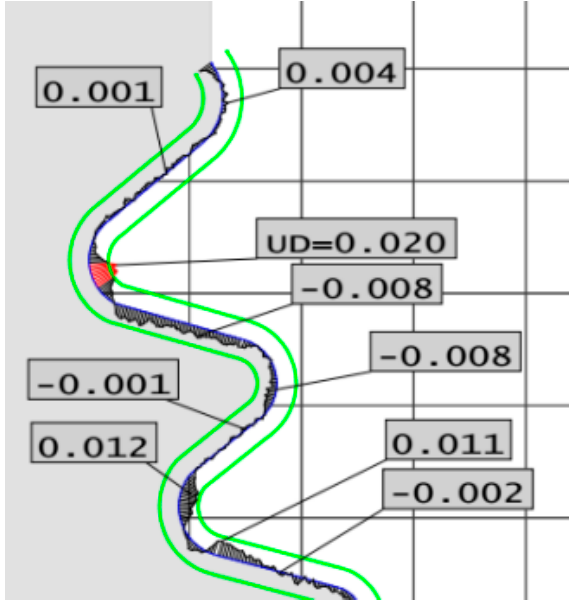
Figure 4. Results after measuring the fir-tree slot profile on the Mitutoyo 9106 Coordinate Measuring